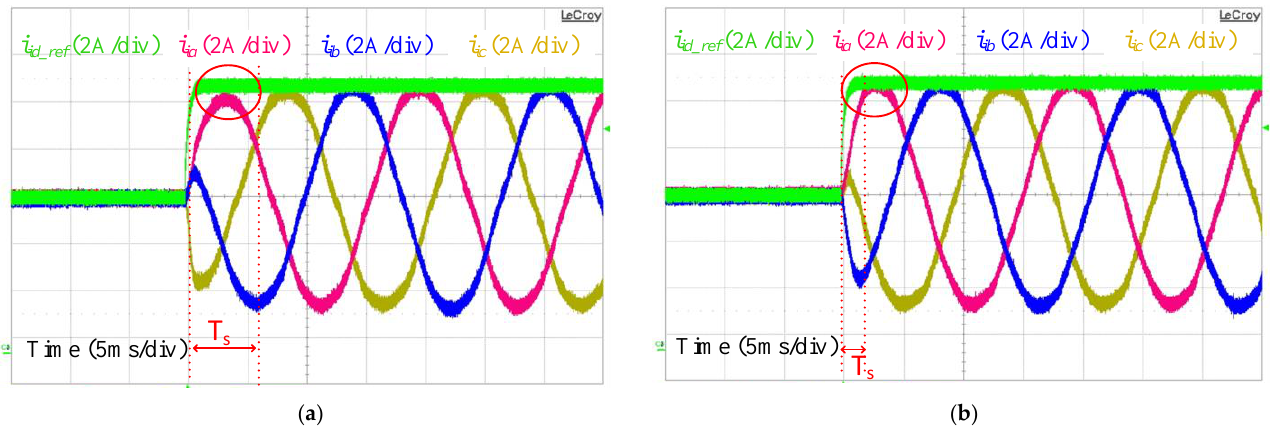
= 4 mH (Figure 25). grid